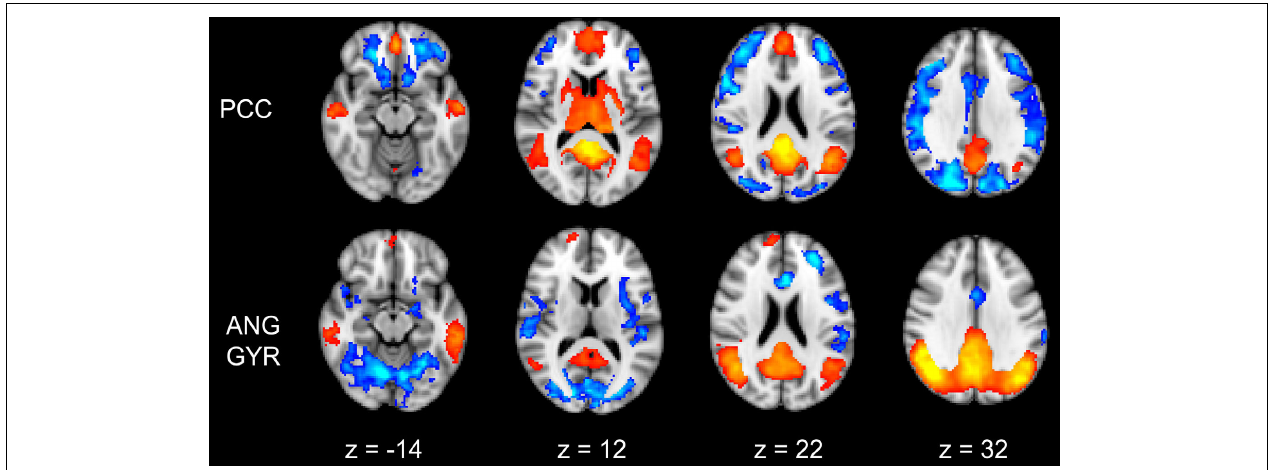
FIGURE 4 | Functional connectivity group maps (GM + , GM − ) of the two DMN ROIs (PCC, AG) that resulted negatively correlated with impulsivity score. In yellow-red color scale are displayed the correlating